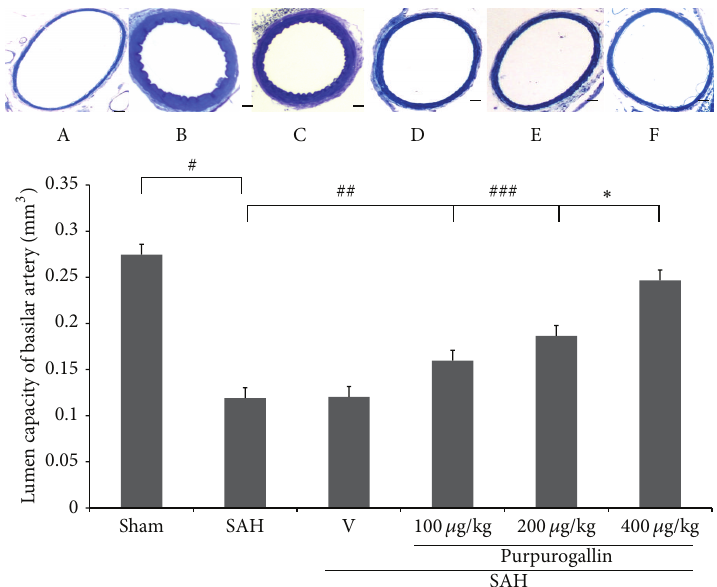
Figure 1: Comparison of lumen cross-sectional capacities of the basilar artery (bottom panel). Top panel represents micrographs of the BAs obtainedfromthehealthycontrols(A),theSAHonlyrats(B),thevehicle-treatedSAHrats(C),SAHratsreceived100 ug/kg/daypurpurogallin treatment (D), SAH rats received 200 ug/kg/day (E), and 400 ug/kg/day purpurogallin treatment (F). Standard bar = 200 𝜇 m. ∗ 𝑃 < 0.01 : compared with the SAH and sham operated group. # 𝑃 > 0.05 : comparison between the SAH group and the controls. ## , ### 𝑃 > 0.05 , ∗ 𝑃 < 0.01 : purpurogallin + SAH groups compared with the SAH group. Data are means ± SEM ( 𝑛 = 9 /group).